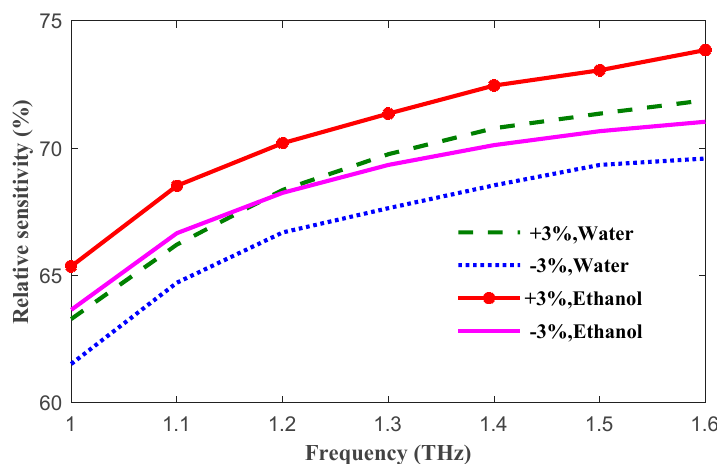
Figure 5. Relative sensitivity of the sensor when the core air hole radius was varied by ±3% for the water and ethanol cases.